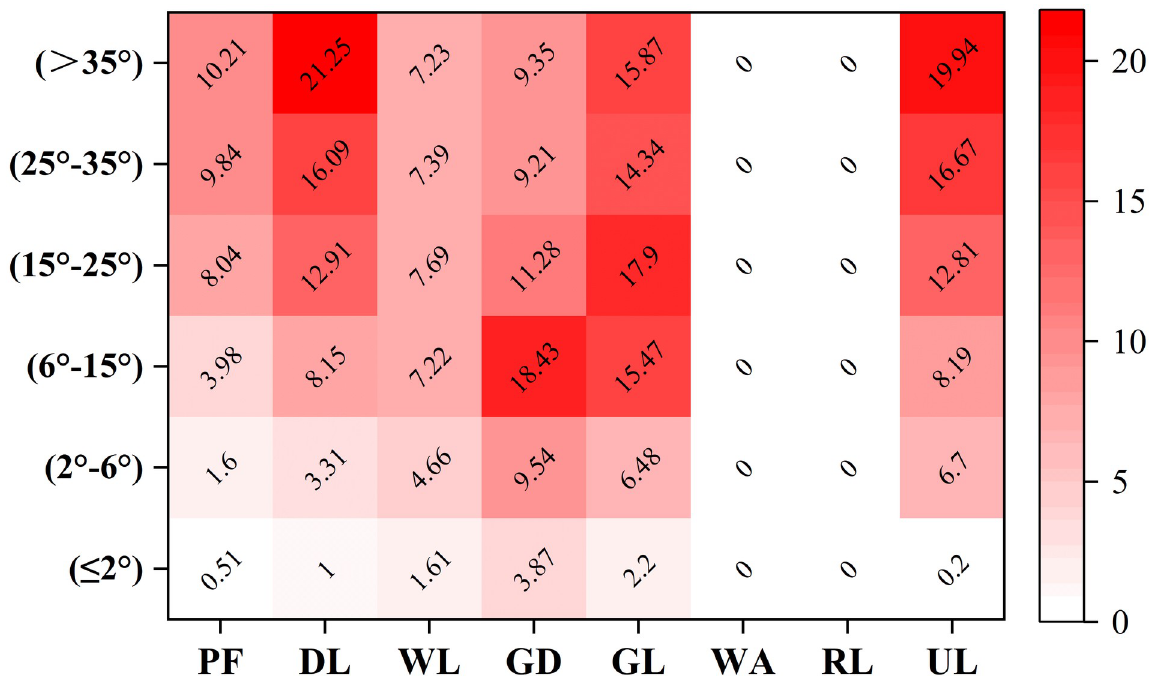
Fig 4. Soil erosion rates for each land use type under different slopes in the study area in 2018. PF—paddy field, DL—dry land, WL— woodland, GD—garden land, GL—grassland, WA—water area, RL—residential land, UL—unused land.